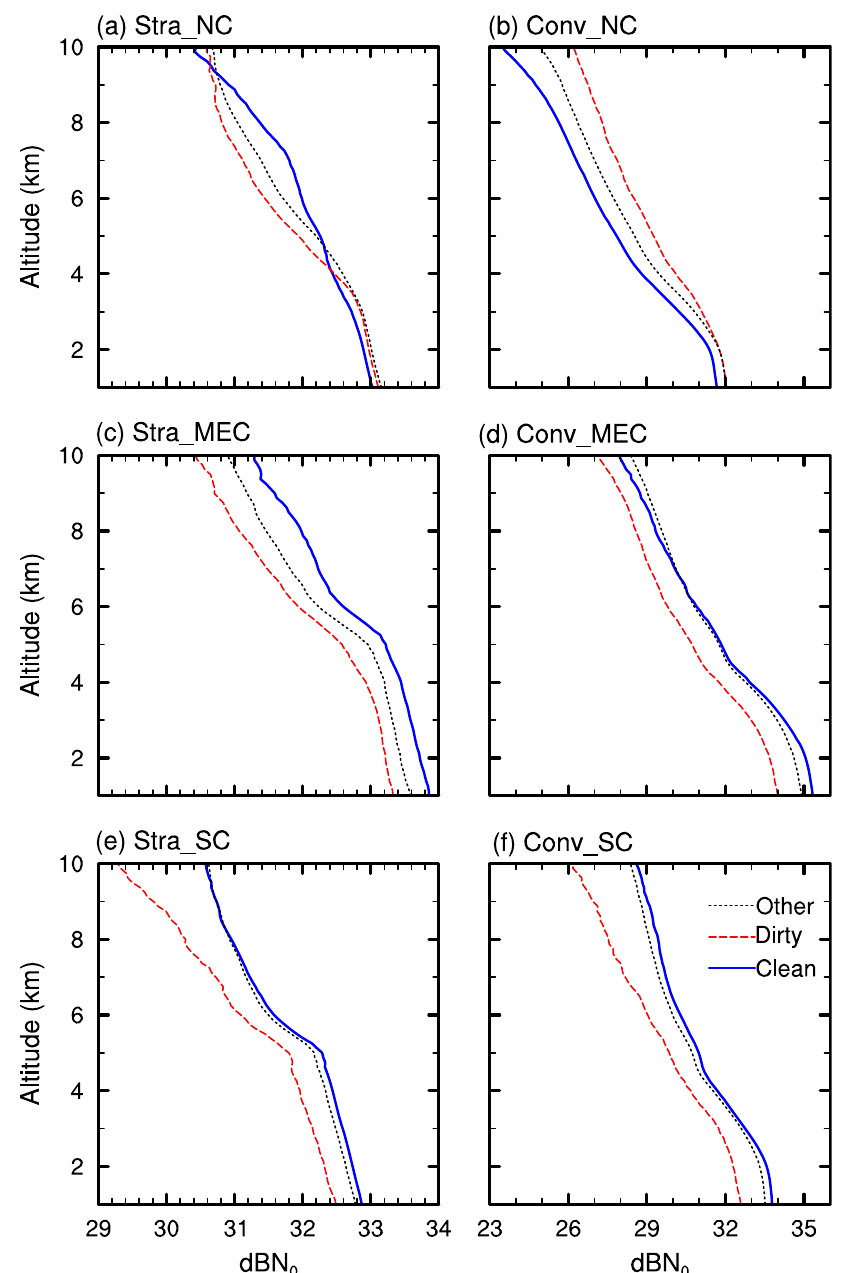
Fig. 3 The droplet concentration (dBN 0 ) pro fi les under “ Clean, ” “ Dirty, ” and “ Other ” conditions. a Stratiform precipitation in NC. b Convective precipitation in NC. c Stratiform precipitation in MEC. d Convective precipitation in MEC. e Stratiform precipitation in SC. f Convective precipitation in